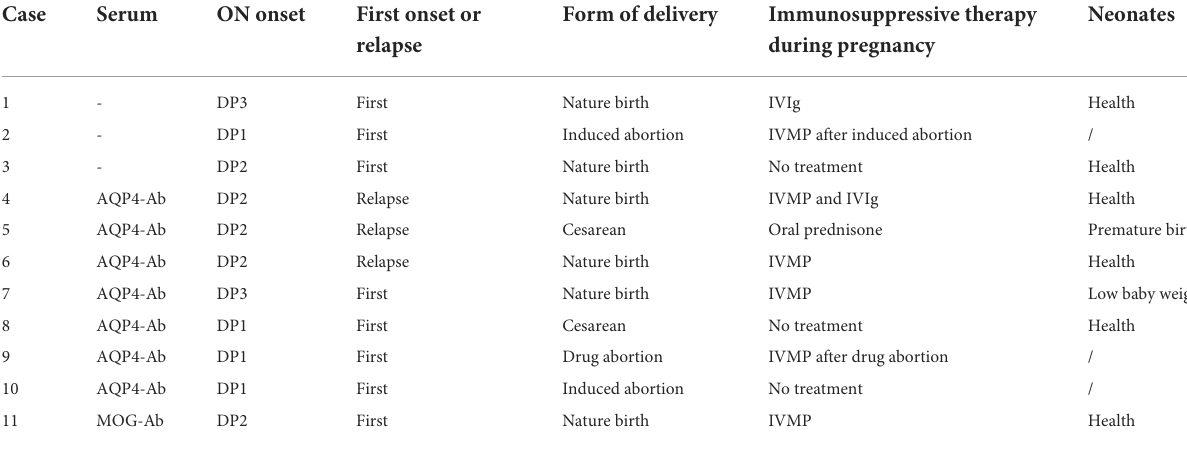
TABLE 3 The treatment and delivery status of the patients with ON attack during